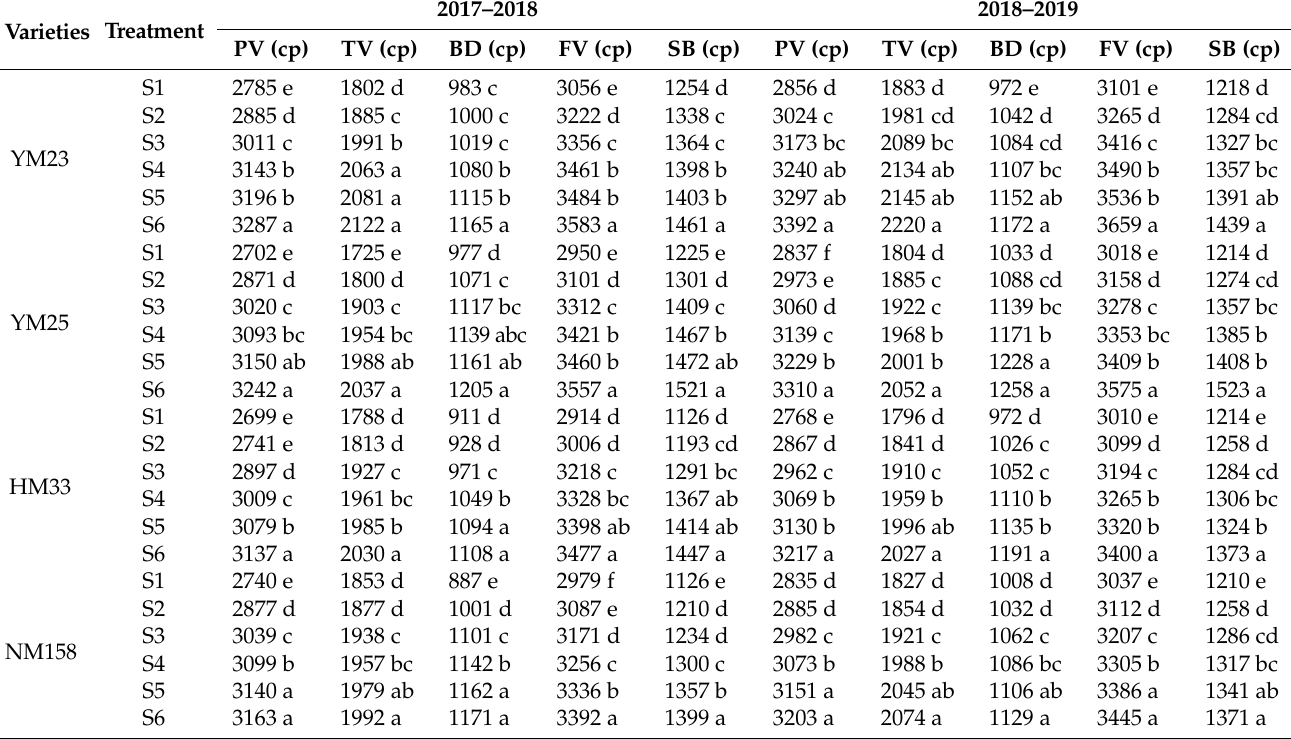
Table 2. Effects of temperature and radiation on the gelatinization of wheat starch after